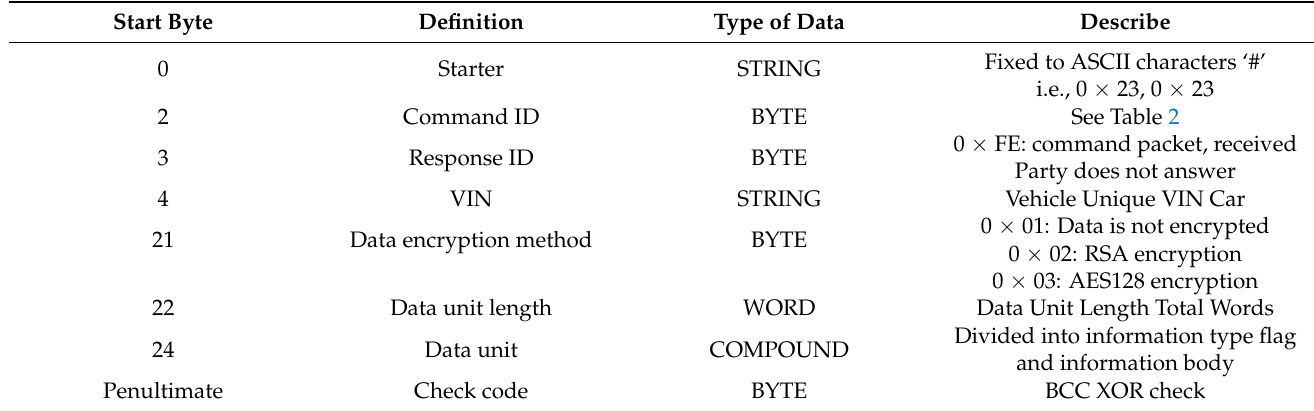
Table 1. Packet structure definition.